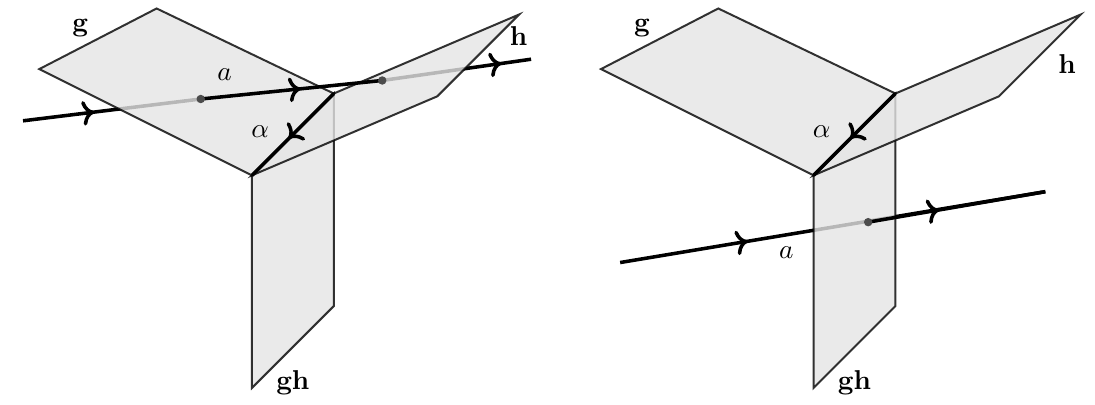
Figure 4 . The line a is acted on by the zero-form symmetry as it punctures the surfaces, and passing the line a by α results in a